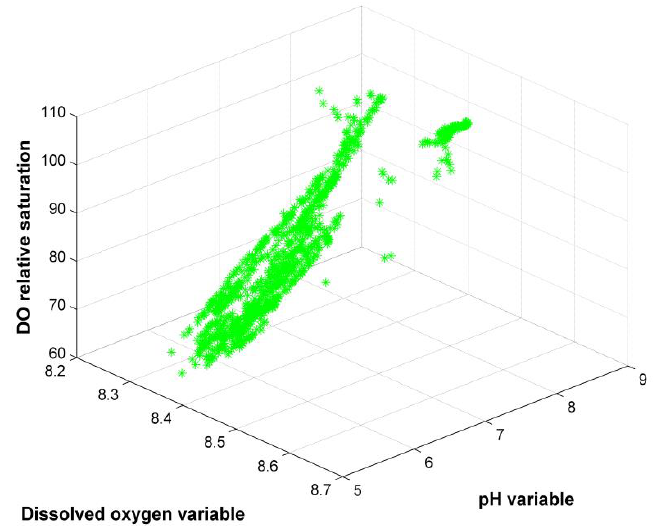
Figure 3. Illustration of the water quality dataset distribution in the training process. DO: dissolved oxygen.